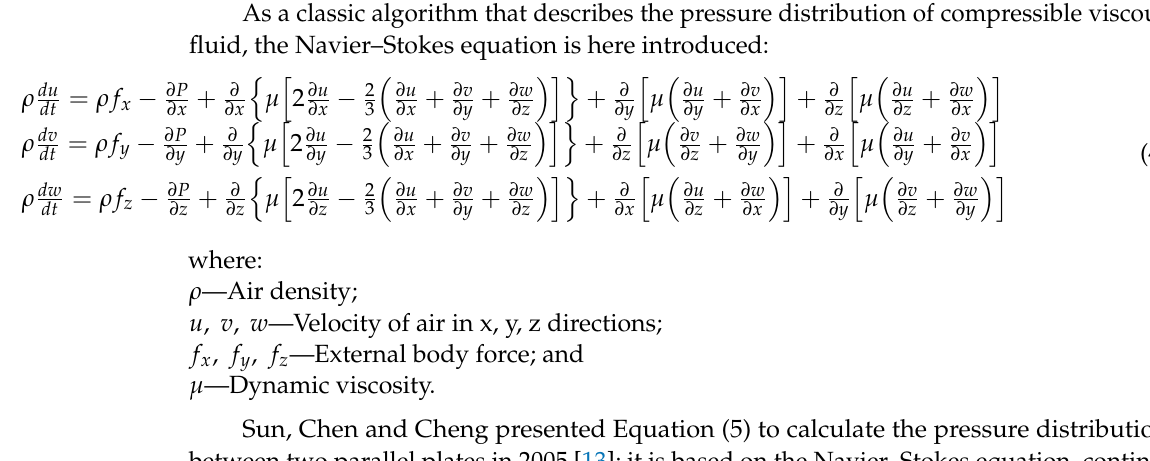
Figure 4. Operating principle of annular orifice aerostatic bearing slideway.